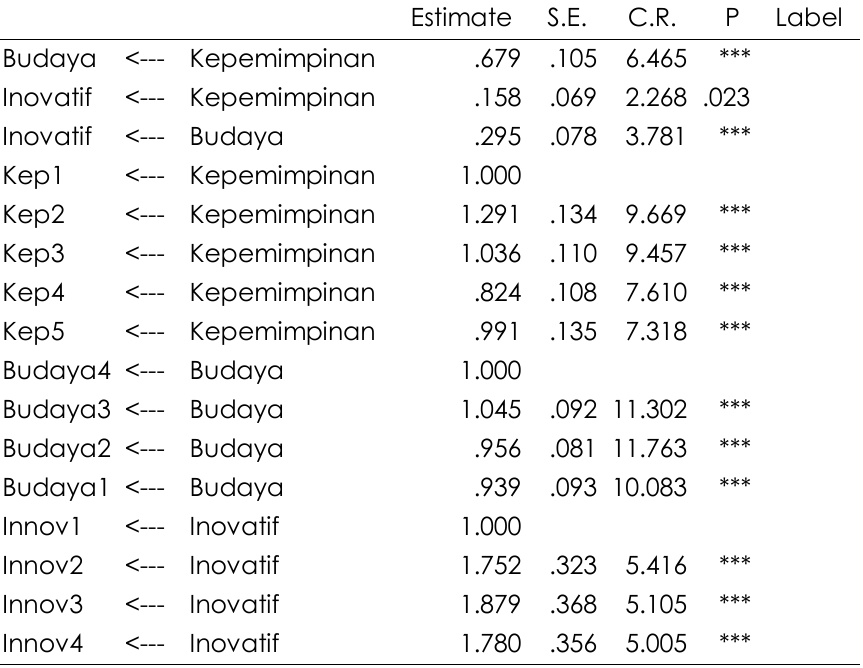
Tabel 7. Estimasi Parameter Regression Weight